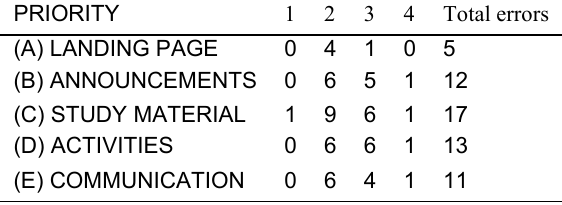
Table 3. Number of accessibility errors by section for